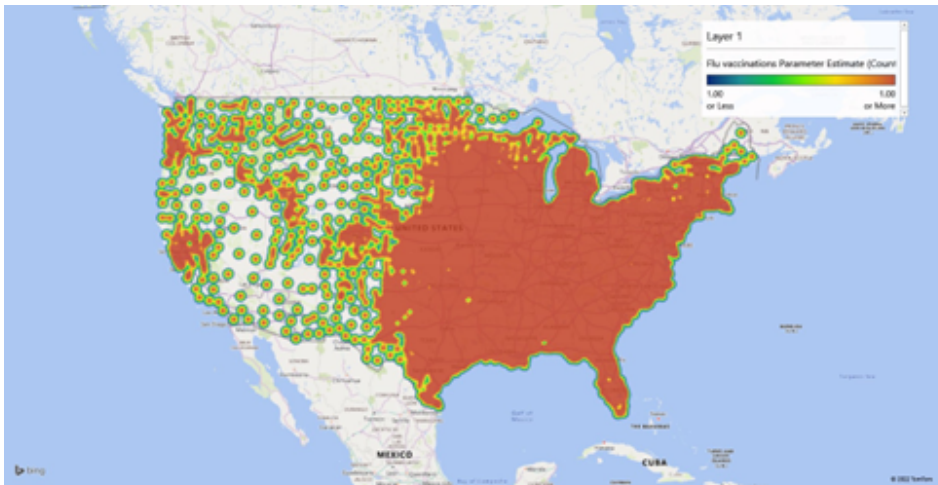
Figure 10. MGWR parameter estimate surfaces for influenza vaccinations which tend to show local patterns of spatial heterogeneity. Green tracts are not statistically different from zero.